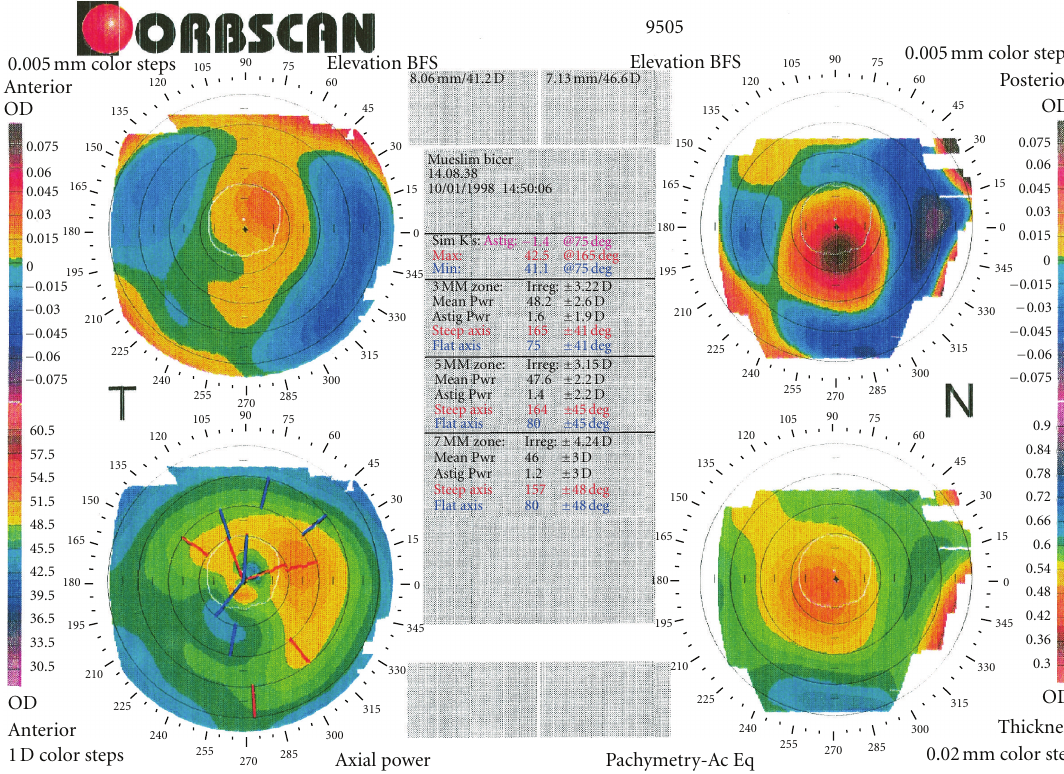
Figure 6: Slit-scanning topography analysis of the posterior corneal curvature (Orbscan) shows the circumscribed protrusion of the posterior surface, located paracentrally inferiorly. The color code indicates a “bulging” of about 75 µ m.